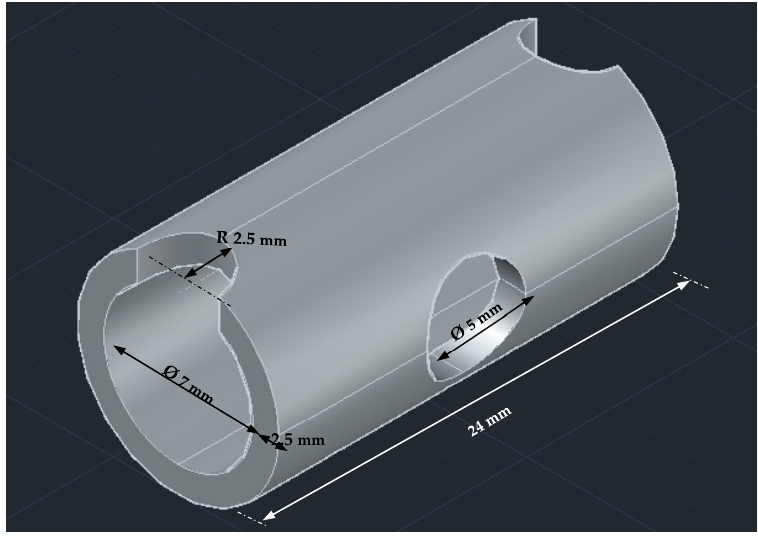
Figure 26. SW Isometric view of the LINE-OX ® porous mullite substrate.